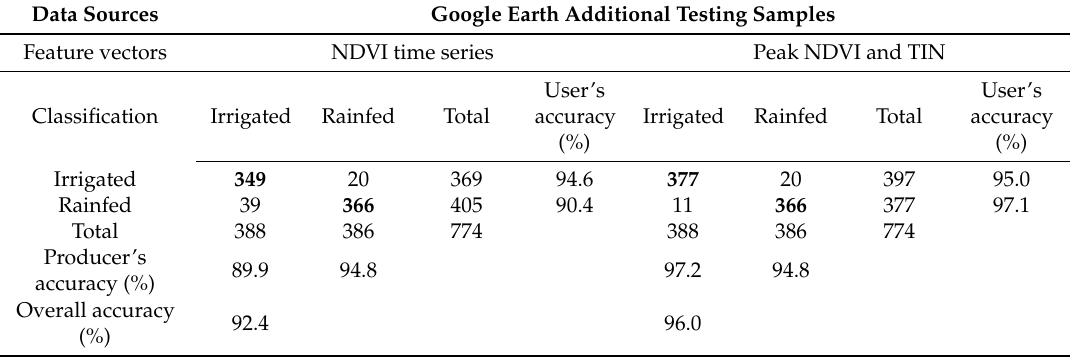
Table 4. Error matrix for SVM classification. TIN,